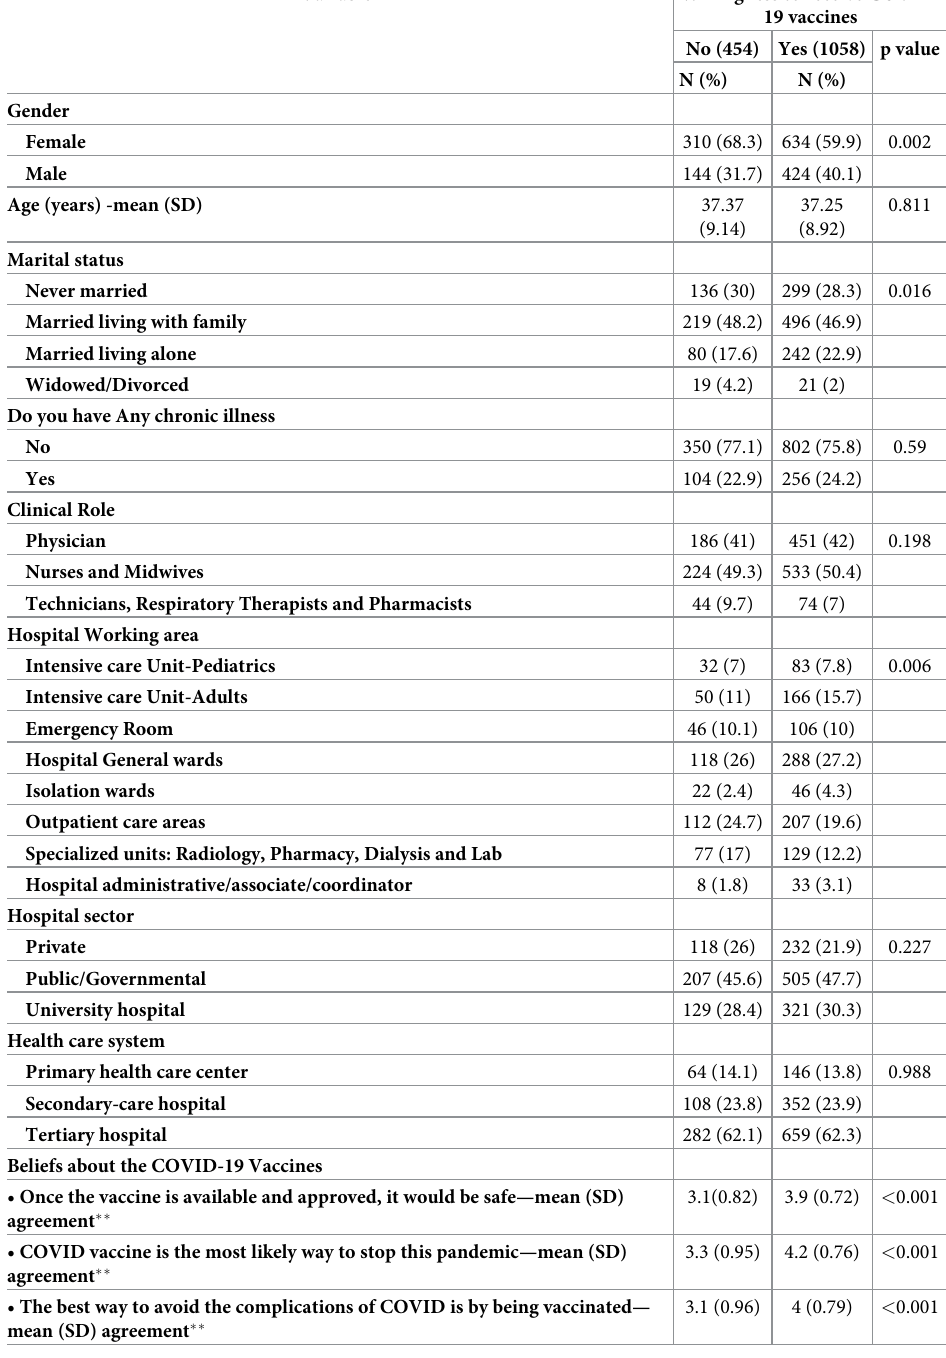
Table 2. Bivariate analysis of health care workers’ willingness to receive potential COVID-19 vaccines (N = 1512).